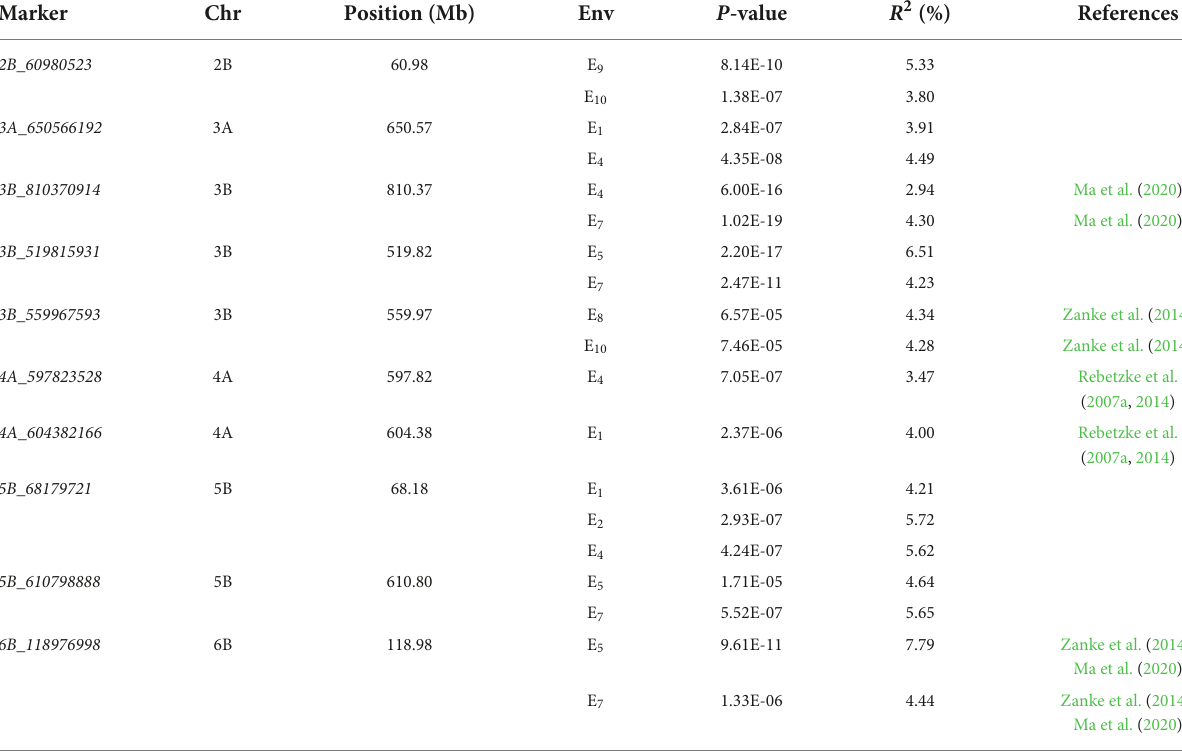
TABLE 2 List of loci detected by genome-wide association study using the 3VmrMLM. Marker Chr Position (Mb) Env P -value R 2